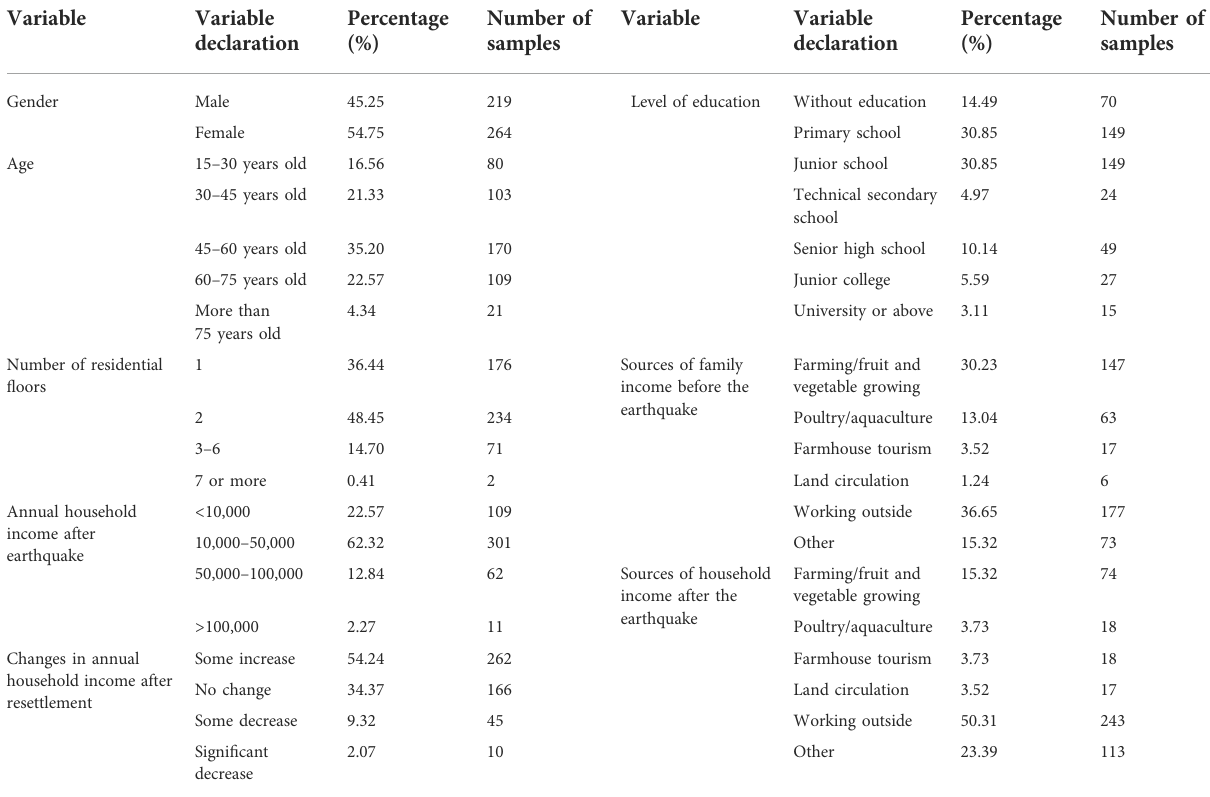
TABLE 5 Basic statistical information about